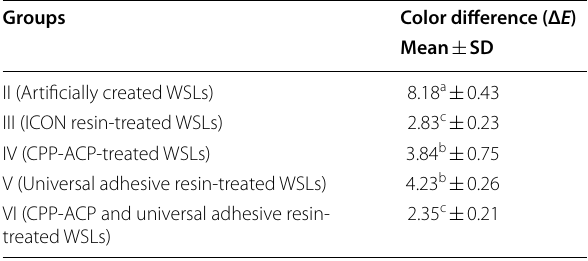
Means with the same superscript letter are not significantly different at p